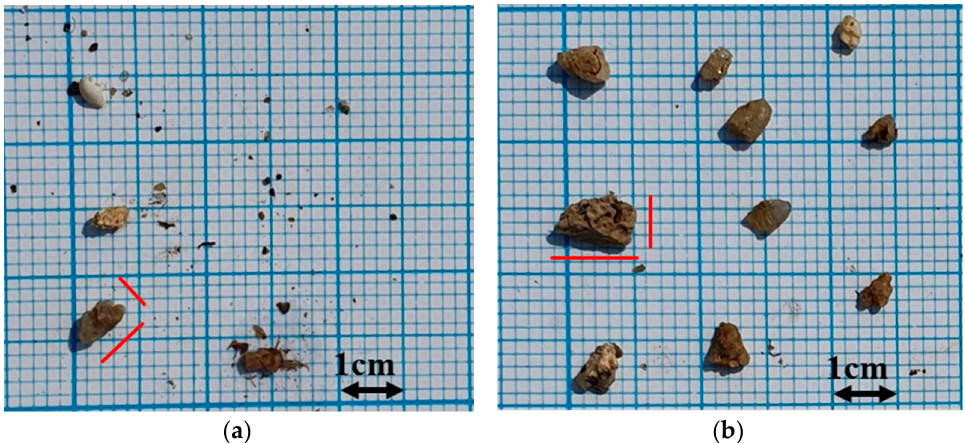
Figure 10. The largest sand grains having been transported from main pipe ( a ) and sub-pipe ( b ).